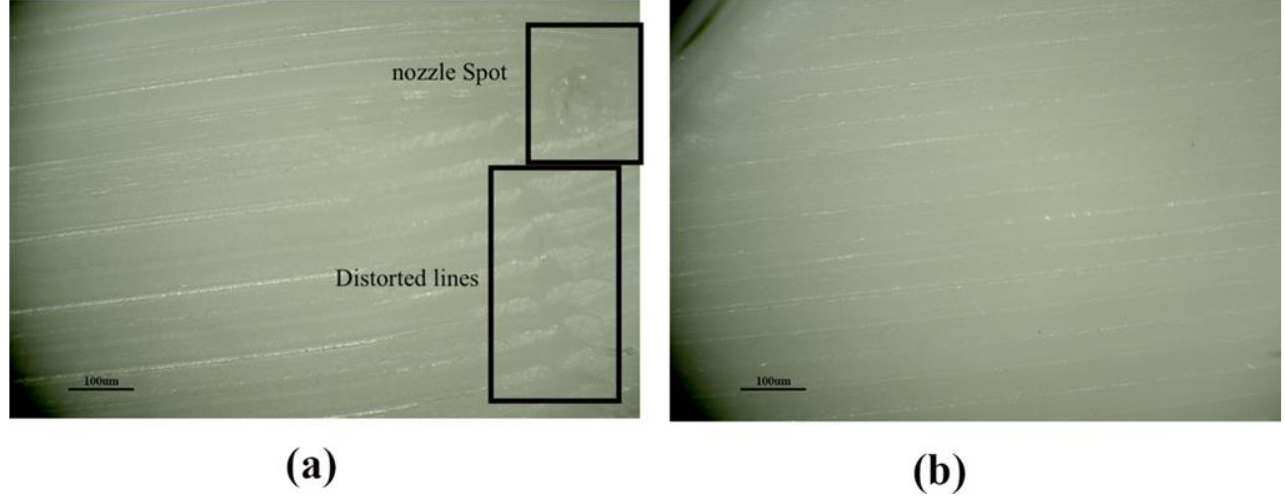
Figure 13. Surface roughness Tester showing the Ra-ABS and Rq-ABS at ( a ) Initial parameters setting at A = 0.3 mm, B = 0.4 mm, C = 100 °C, D = 2, E = 230 °C, F = 60 mm/s, and G = 0.16 mm; ( b ) Taguchi optimal settings at A = 0.3 mm, B = 0.3 mm, C = 95 °C, D = 1, E = 235 °C, F = 50 mm/s, and G = 0.08 mm.